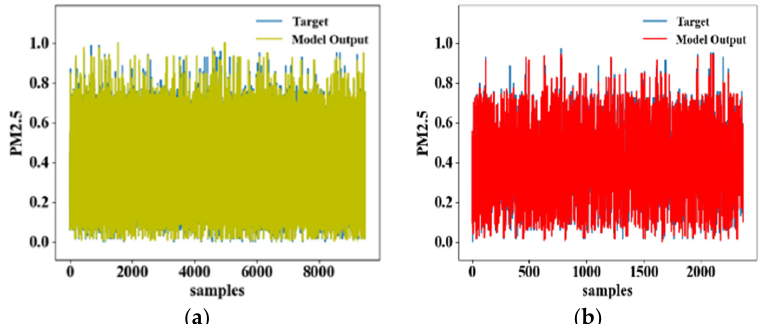
Figure 12. Learning results of the decision tree model: ( a ) training set and ( b ) testing set.